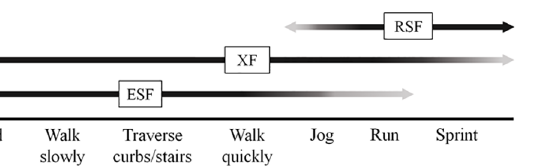
Fig 2. Activities along the mobility spectrum that ESF, RSF, and XF are estimated to span for most prosthetic limb users. The black sections of the arrows indicate that the foot is well-designed for these activites, the faded sections indicate that the foot design can be used for these activities, however, performance may be